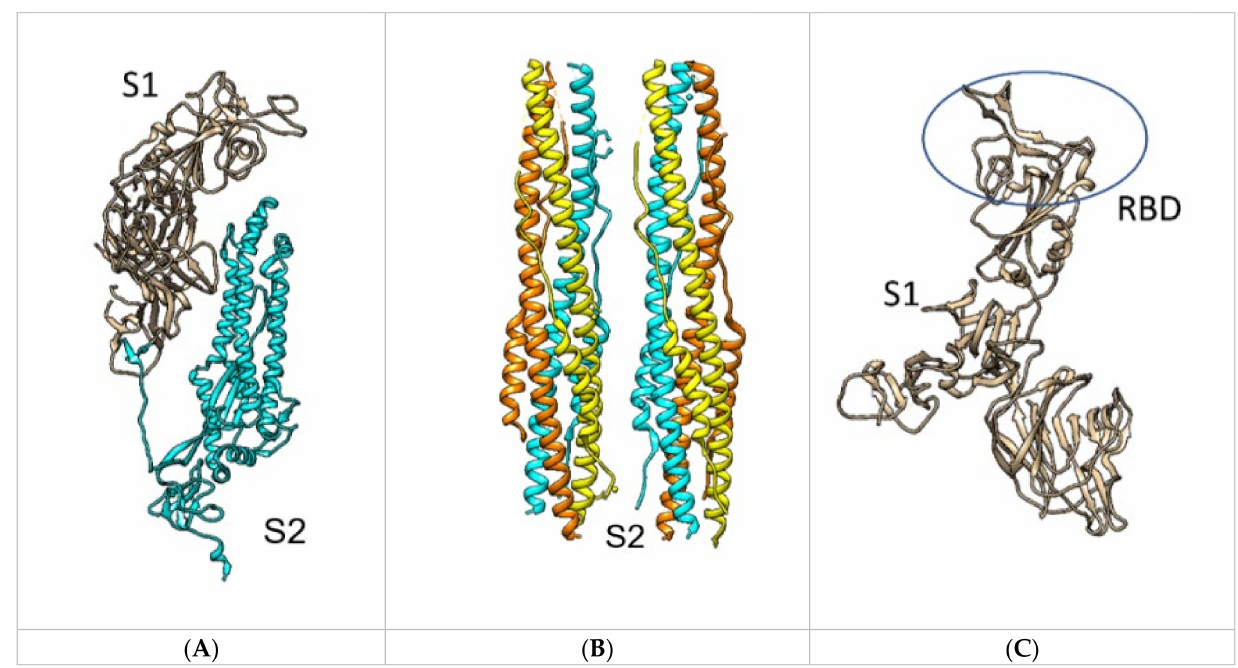
Figure 2. ( A ) Single chain in trimeric spike protein with subunit S1 (Tan) and S2 (Cyan) in 7A94. ( B ) Post-fusion conformation of all S2 units in the trimeric spike in 6LXT. ( C ) S1 subunit, with the RBD highlighted in 7A94